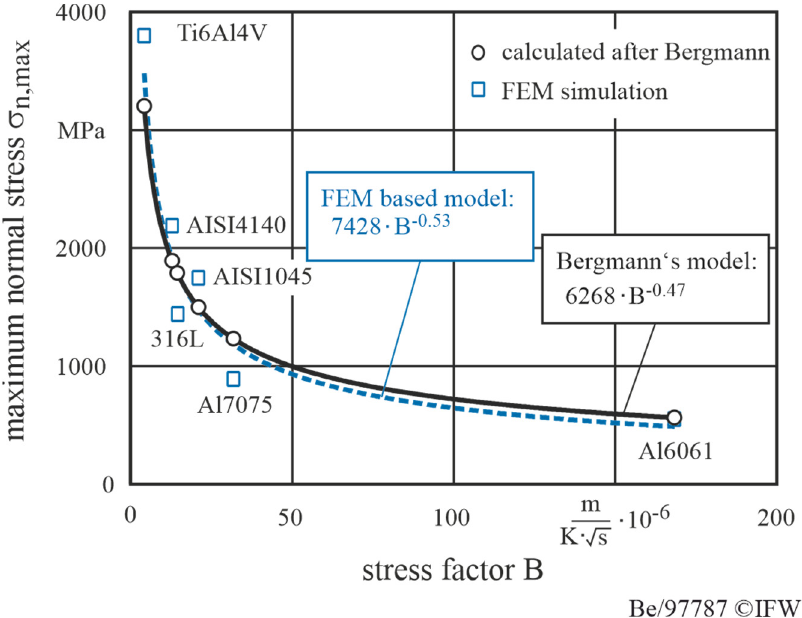
Figure 7. Validation of the simulated maximum normal stresses as a function of the workpiece properties.